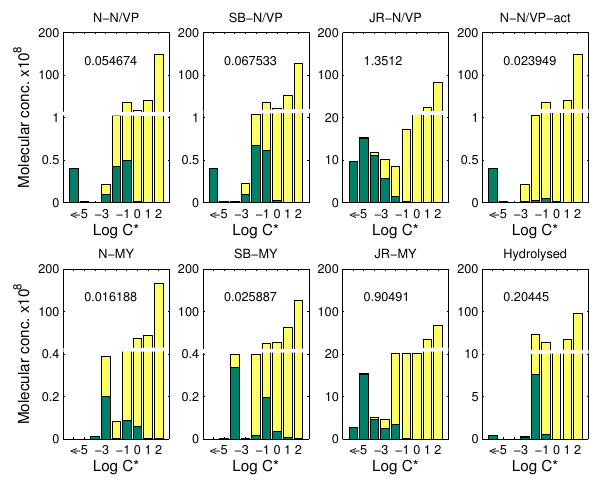
Fig. 4. Predicted binned component volatility for 2742 MCM compounds (except panel 8: 2727 compounds) with concen- trations taken from the standard scenario (1.0/1.0/1.0 NO x - SF/AVOC-SF/BVOC-SF) with T = 293 . 15K, %RH = 70 and 3.0µgm − 3 involatile core. The abscissa is the base 10 logarithm of the saturation concentration of the components in the respec- tive volatility bin, while the y-axis gives the cumulative molecular concentration (in moleculescm − 3 ) for each bin: please note scale change half way up the y-axis in each panel. The green bars cor- respond to the particulate and the yellow to the vapour phase. The total condensed SOA mass (in µgm − 3 ) is indicated on each